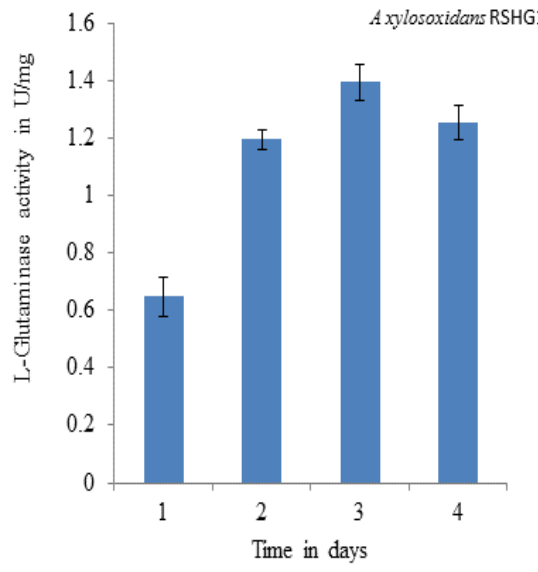
Figure 3. Production of glutaminase by A. xylosoxidans RSHG1 bacteria in fermentation media at 37 °C, pH 6.8.